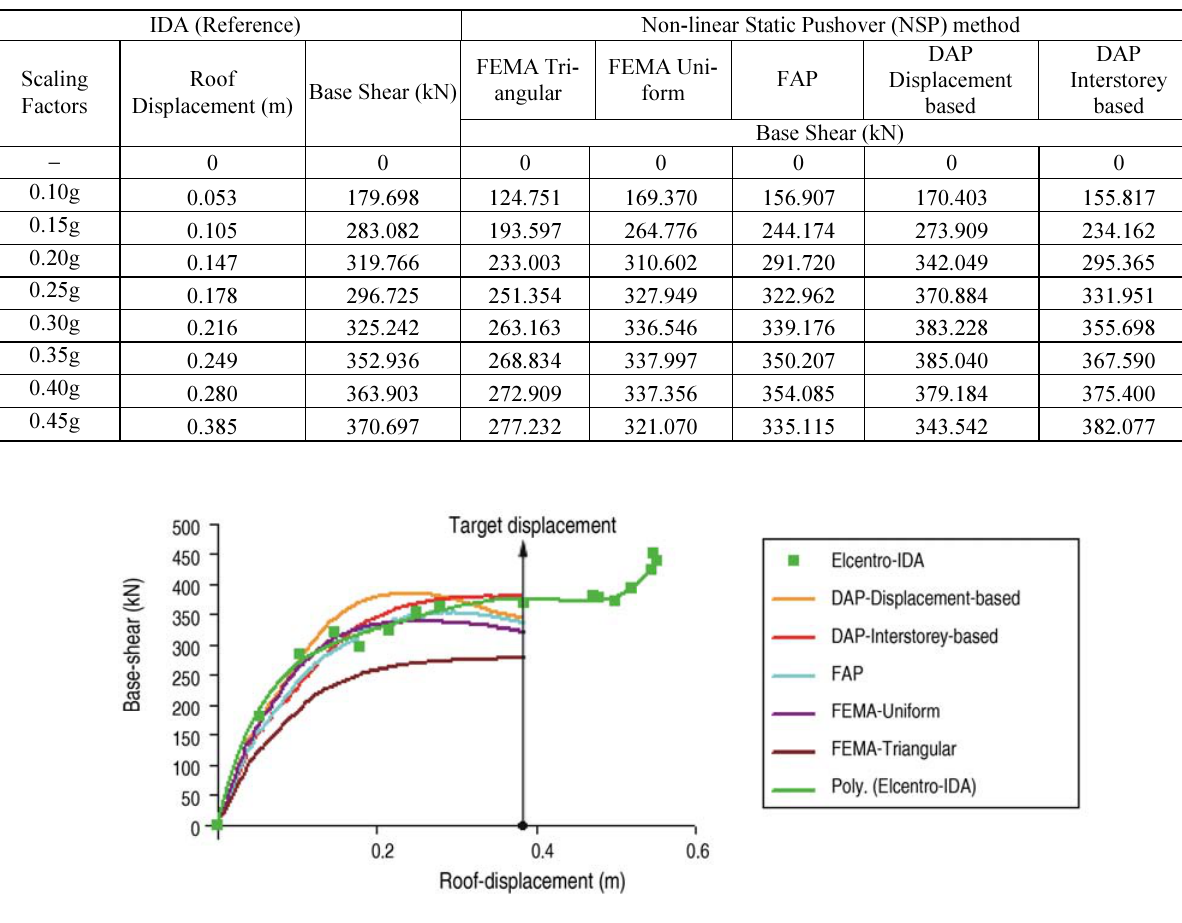
Table 4. Numerical comparing the static capacity curves with IDA results